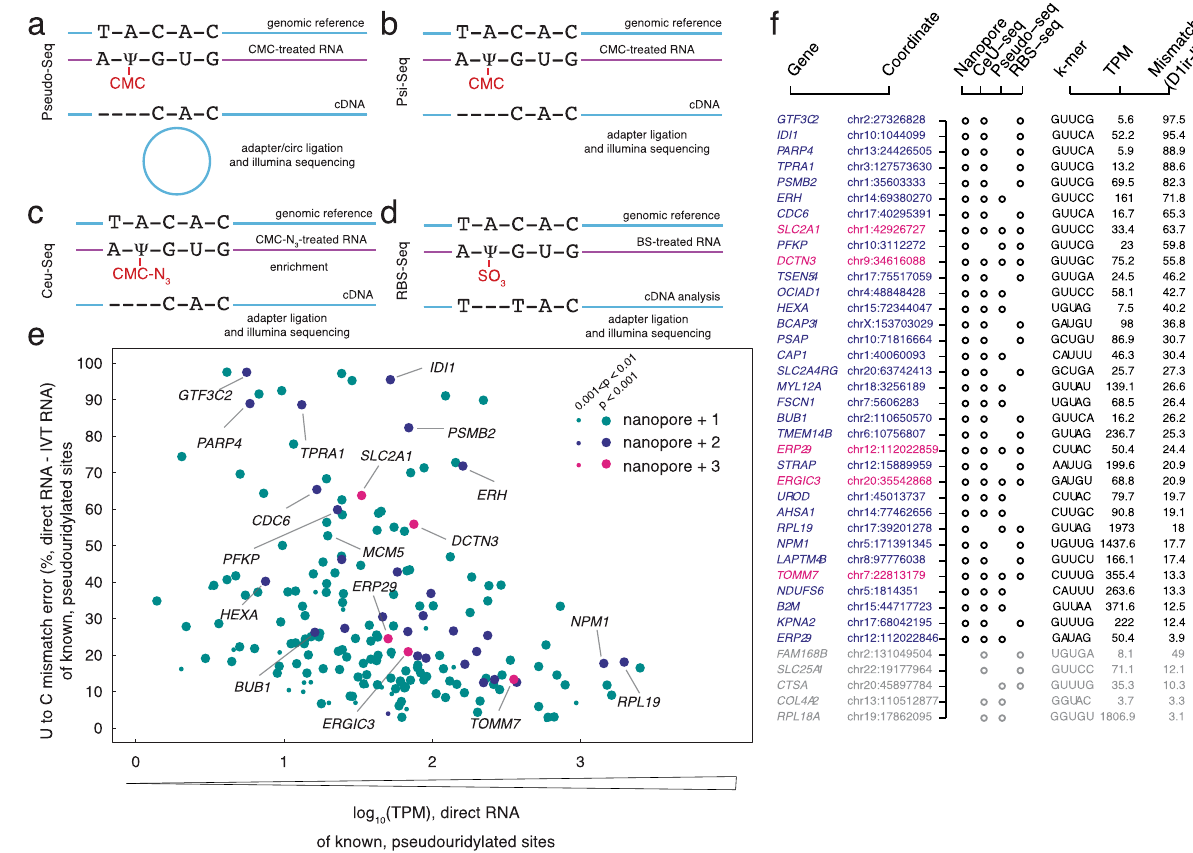
Fig. 3 | Previously annotated ψ modi fi cations in the human transcriptome are validated by nanopore sequencing. a The schematicwork fl ow of the CMC-based methodsthathavedetected ψ modi fi cationinthehumantranscriptome. a Pseudo- Seq,( b ) Ψ -Seq,( c )CeU-Seq,and( d )modi fi edbisul fi tesequencing(RBS-Seq). e U-to- Cmismatcherror(%)ofthemergedreplicatesofdirectRNAofknown ψ sitesversus the log 10 (TPM) of merged direct RNA sequencing replicates. All targets shown are identi fi ed from the direct RNA sequencing data as likely to be